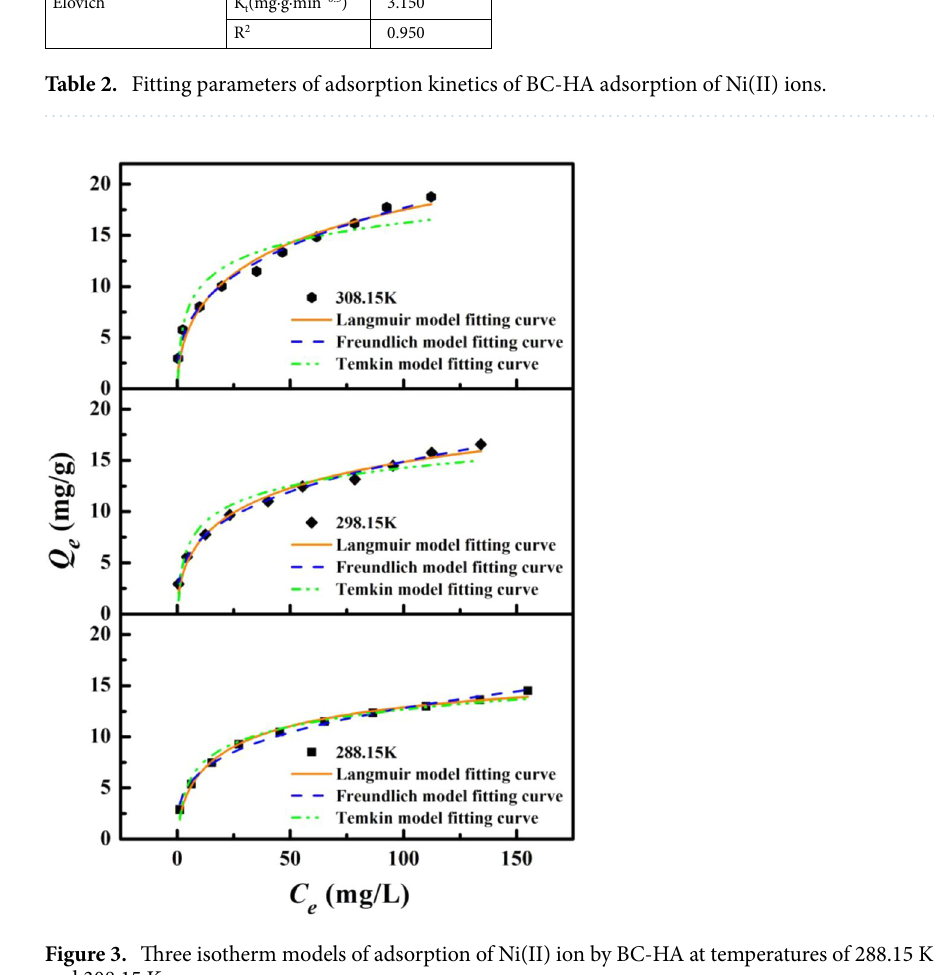
Figure 3. Three isotherm models of adsorption of Ni(II) ion by BC-HA at temperatures of 288.15 K, 298.15 K and 308.15